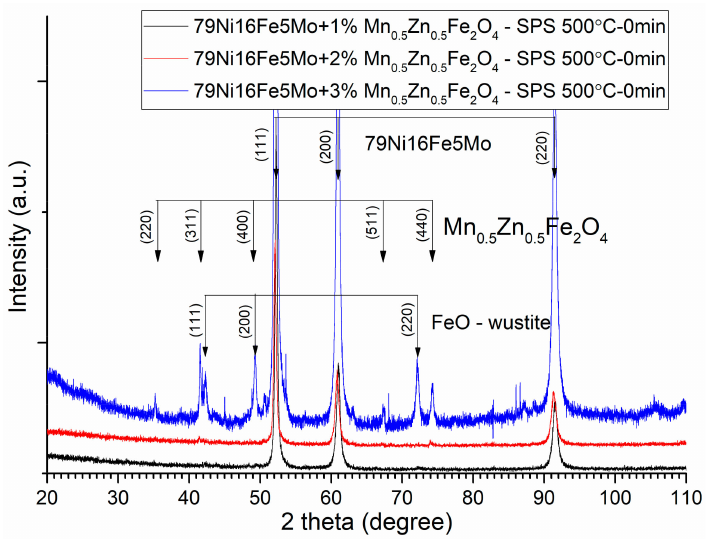
Figure 9. XRD patterns of the supermalloy/Mn 0.5 Zn 0.5 Fe 2 O 4 composite compacts with 1, 2, and 3 wt.% of MnZn ferrite obtained by SPS at sintering temperature of 500 ◦ C. For clarity, the XRD patterns have been shifted